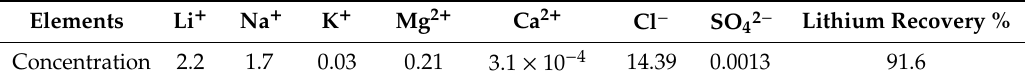
Table 5. The compositions of the permeate flow produced by NF (g · L − 1 ).